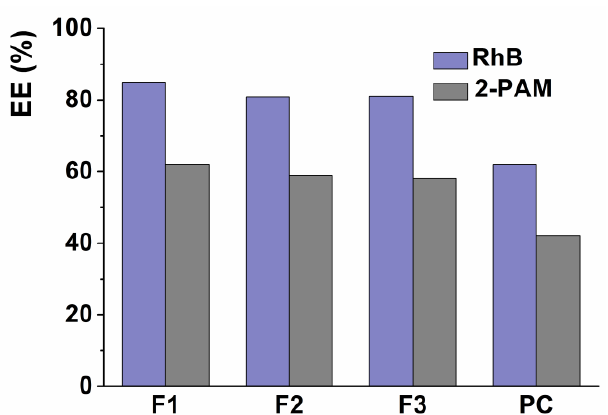
Figure 5. Encapsulation efficiency of RhB- and 2-PAM-loaded liposomes and chitosomes (contain- 0.05% ing 0.05% Cs).